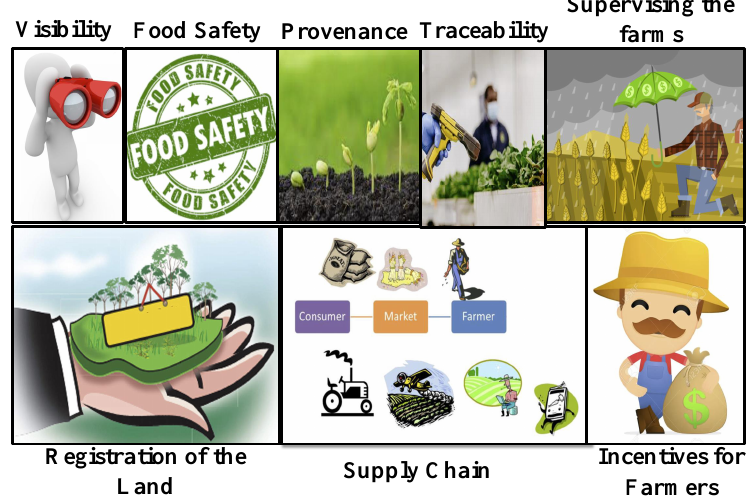
Figure 5. Blockchain use cases in smart agriculture.